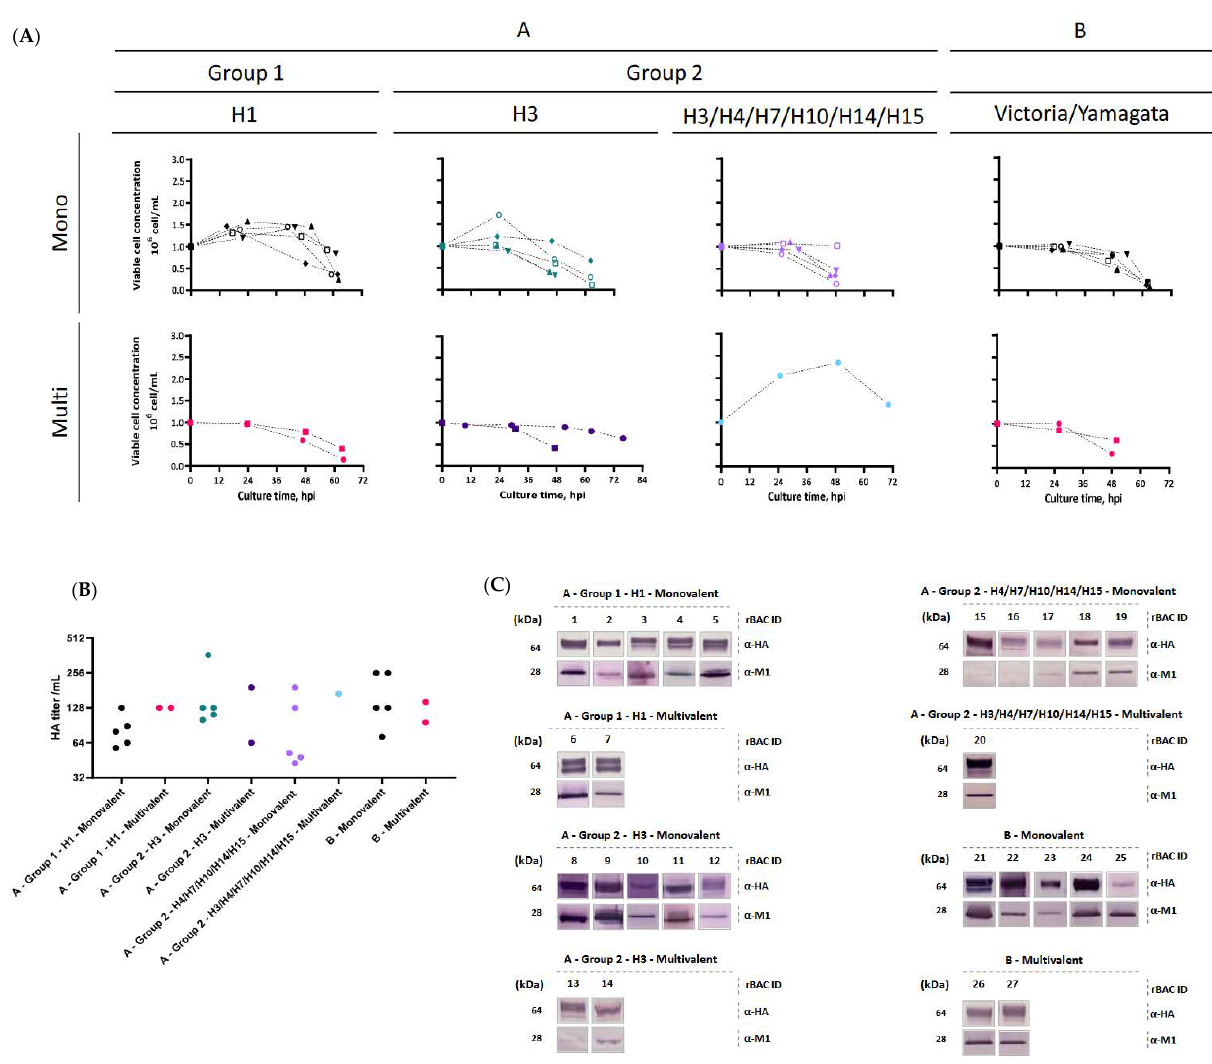
Figure 1. Production of influenza HA-VLPs at the 2 L bioreactor scale. ( A ) Cell growth kinetics. ( B ) Extracellular HA titer at time of harvest. ( C ) Identification of influenza HA and M1 proteins by Western blot. The color code in subfigures A and B corresponds to: black icons — influenza A group 1 H1 monovalent cell growth kinetics; red icons — influenza A group 1 H1 multivalent cell growth kinetics; green icons — influenza A group 2 H3 monovalent cell growth kinetics; purple icons — influenza A group 2 H3 multivalent cell growth kinetics; lilac icons — influenza A group 2 H4/H7/H10/H14/H15 monovalent cell growth kinetics; light blue icons — influenza A group 2 H4/H7/H10/H14/H15 multivalent cell growth kinetics; dark grey icons — influenza B monovalent cell growth kinetics; pink icons — influenza B multivalent cell growth kinetics.